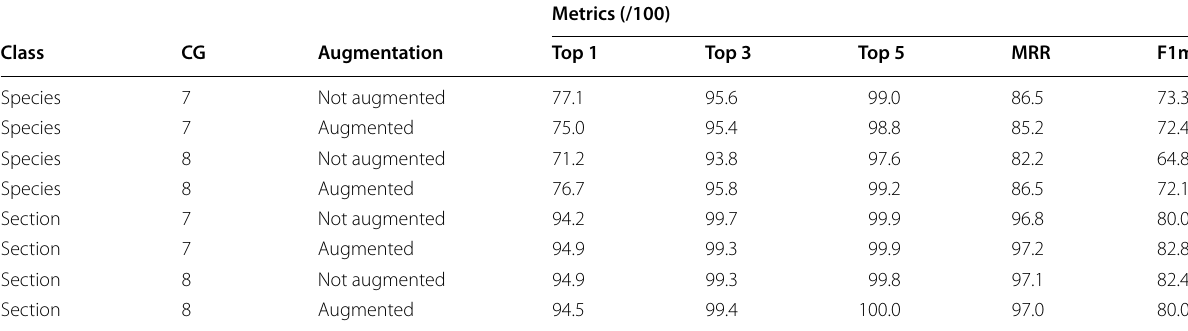
Table 5 Comparison of results using augmented and non-augmented